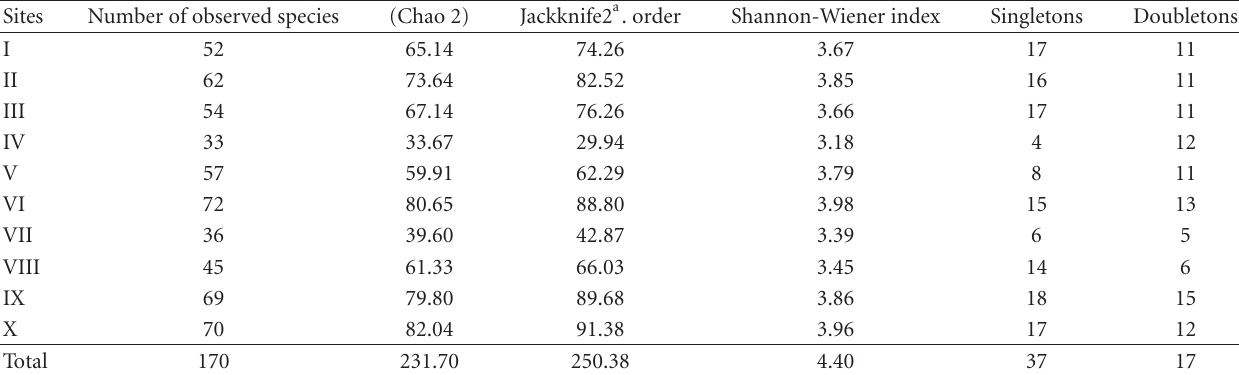
Table 3: Species richness, estimated richness (Chao 2, Jackknife 2), diversity index, and the number of “singletons” and “doubletons”. Sites Number of observed species